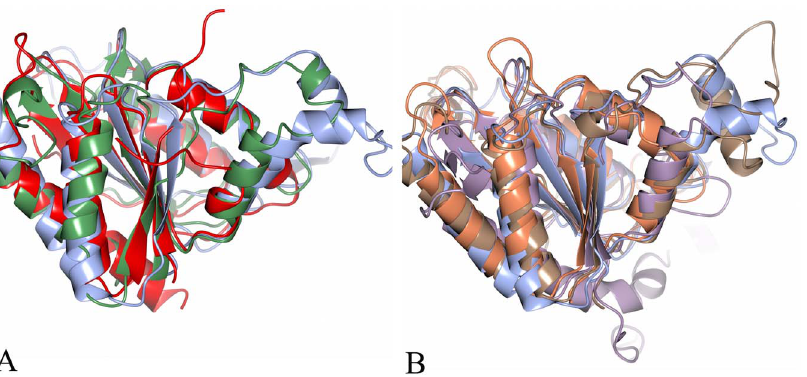
Figure 5. Structures of azoreductase homologues overlaid onto paAzoR1. (A) Structures of ArsH (PDB: 2Q62 - lilac), ecMdaB (PDB: 2B3D – coral) and hNQO2 (PDB: 2QR2 - brown) overlaid onto paAzoR1. (B) Structures of PA0949 (PDB: 1ZWL - red) and PA1204 (PDB: 1 6 77 - green) overlaid onto paAzoR1. In all cases, one monomer of the dimer is shown. In both cases, paAzoR1 is in blue (PDB: 2V9C). All alignments were carried out via secondary structure matching and images were generated in CCP4MG